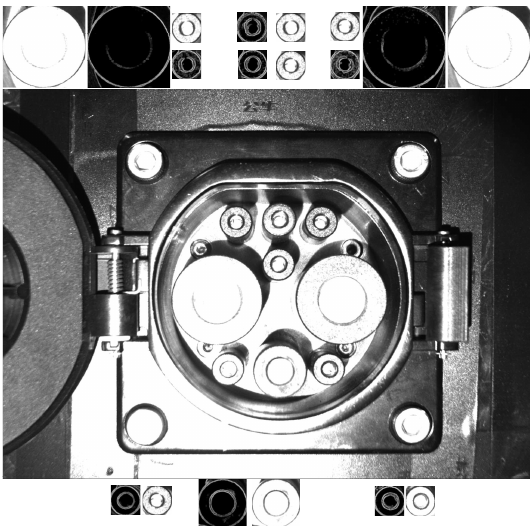
Figure 7. Template extraction